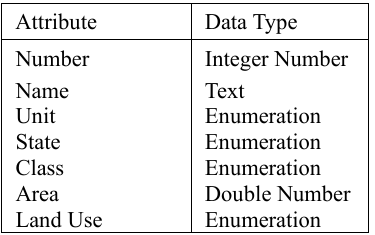
Table 1 . Attributes of legal interests